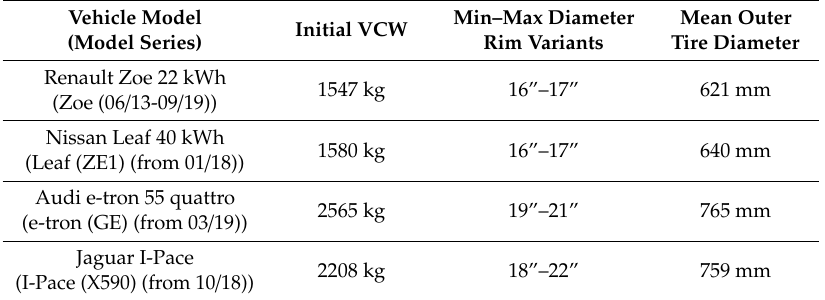
Table 2. Reference vehicles used for analyzing secondary e ff ects on the wheel